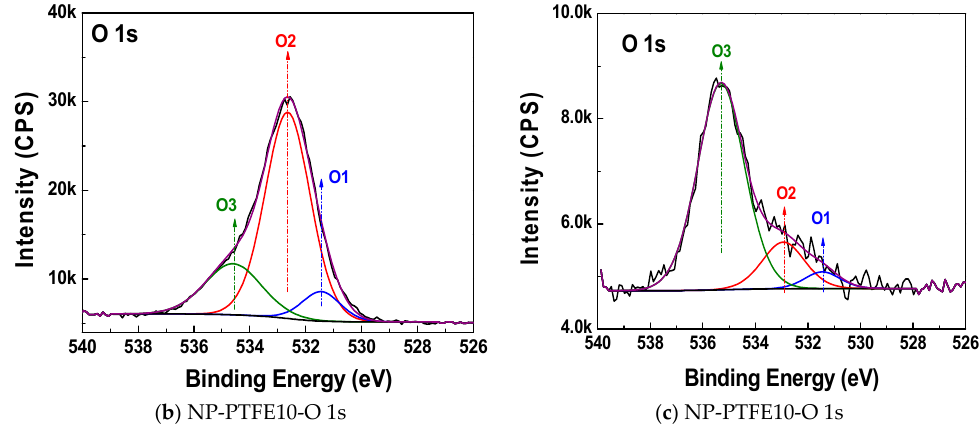
Figure 5. O 1s peak of the new pressboard, pressboard surface coated PTFE film for 10 min and 20 min.